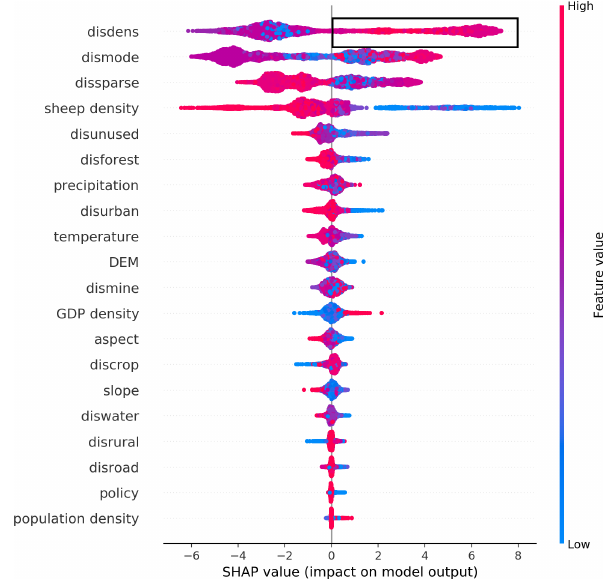
Figure 6. Driver ranking by SHAP values based on the training dataset (66% of sample size) using the over-sampling method.